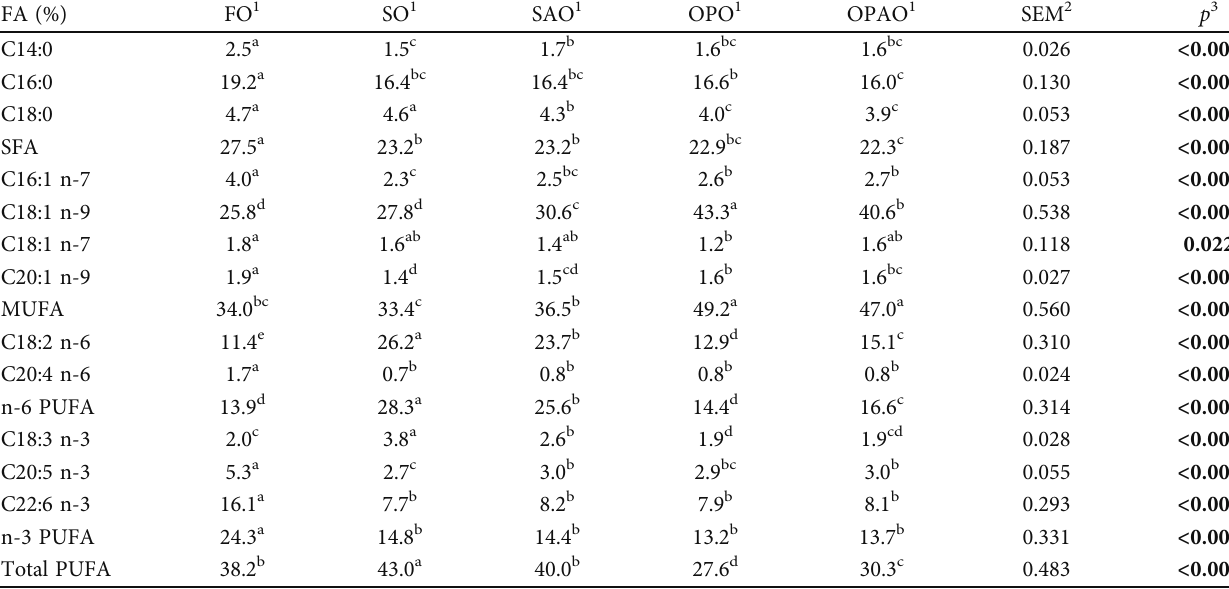
Table 4: Fatty acid pro fi le of fresh fi llets coming from fi sh fed with the fi ve experimental diets. FA (%) FO